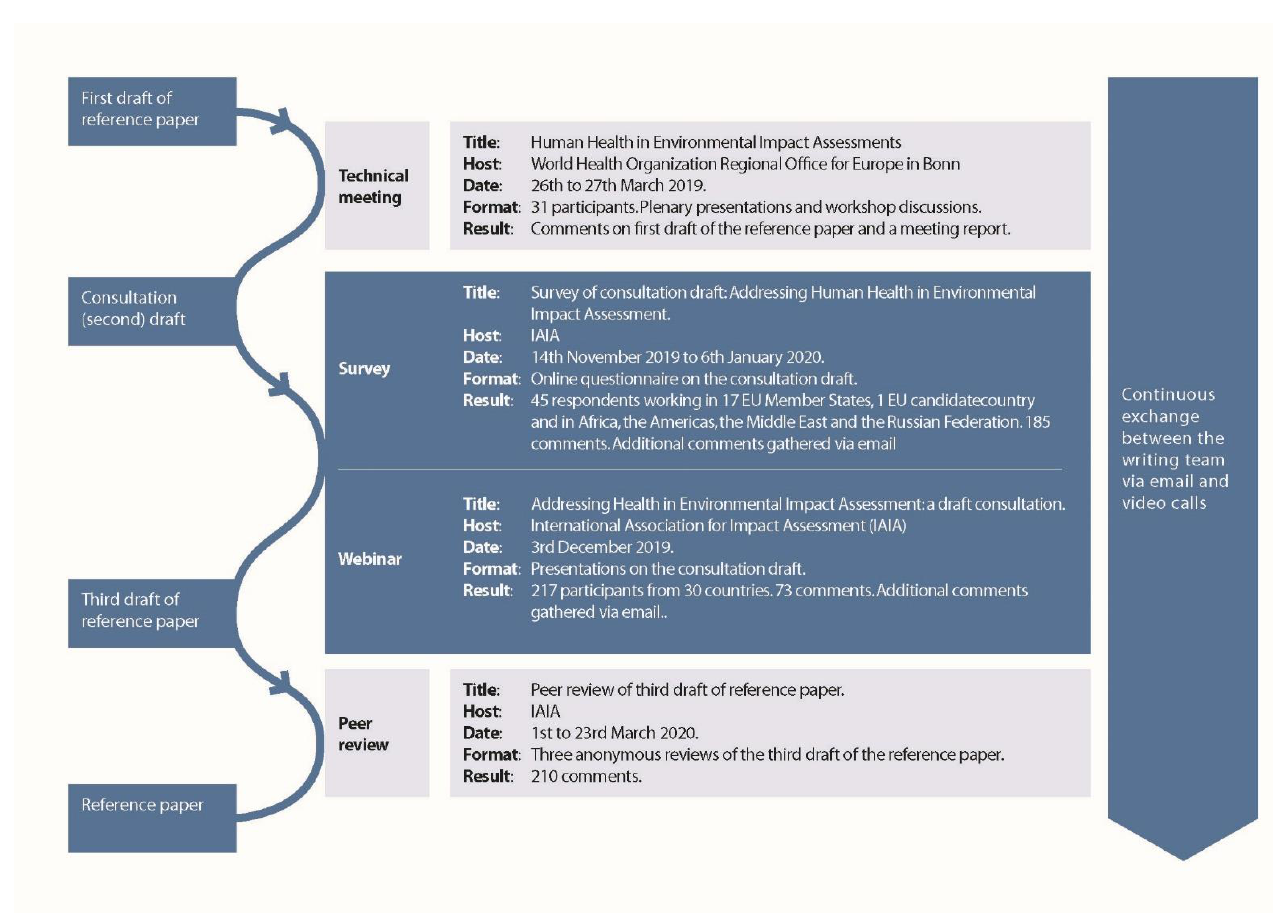
Figure 1. Preparing the reference paper. Figure from Cave et al. [1]. Reproduced with permission from Cave et al. Human Health: Ensuring a High Level of Protection. A Reference Paper on Addressing Human Health in Environmental Impact Assessment as Per EU Directive 2011/92/EU Amended by 2014/52/EU; published by International Association for Impact Assessment and European Public Health Association, 2020.